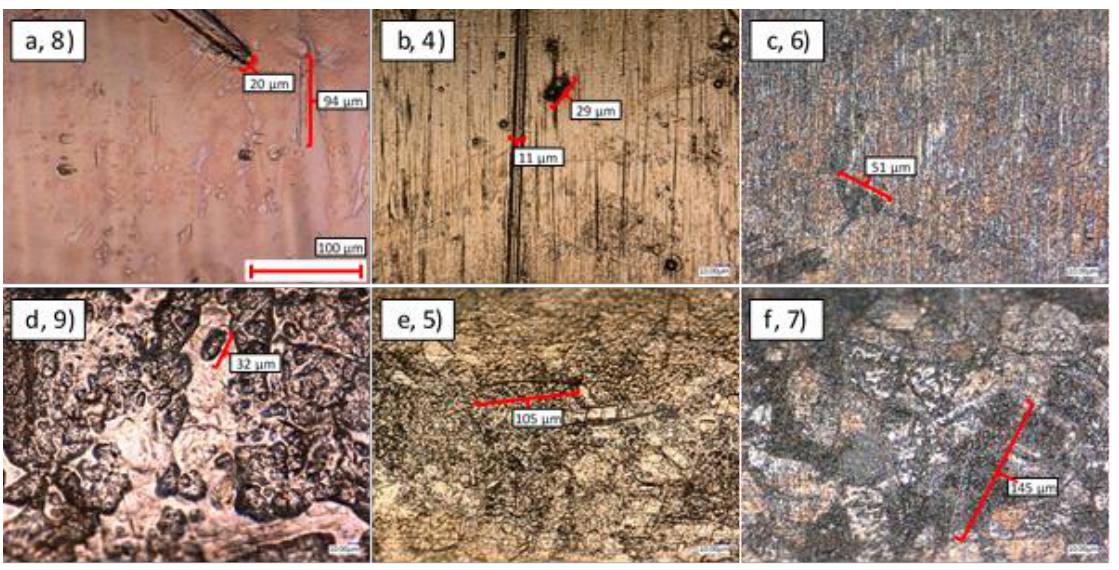
Figure 12. Optical microscopy of the external surface of SS-coated samples: ( a – c ) thin-walled pipes, ( d – f ) thick-walled pipes, ( a , d ) NiCu-coated, ( b , e ) NiAu-coated, ( c , f ) Ni-coated.